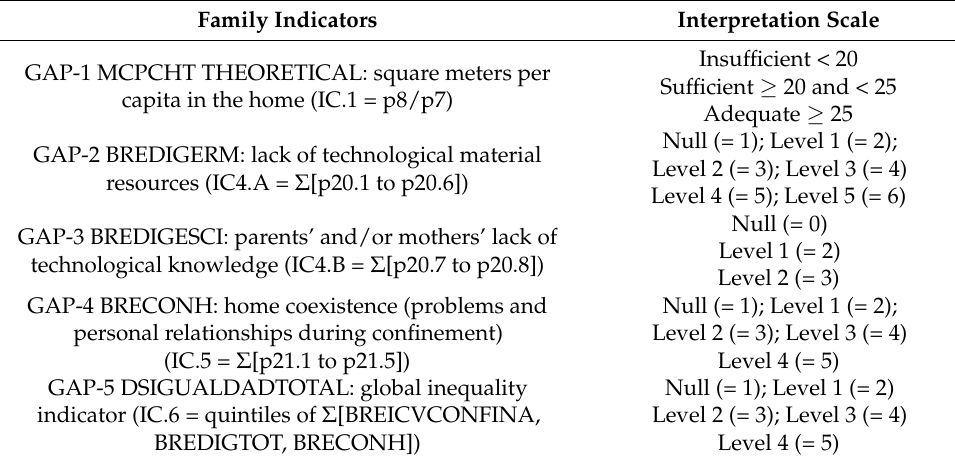
Table 5. Compound Indicators of Gaps about School at Home. Family Indicators Interpretation